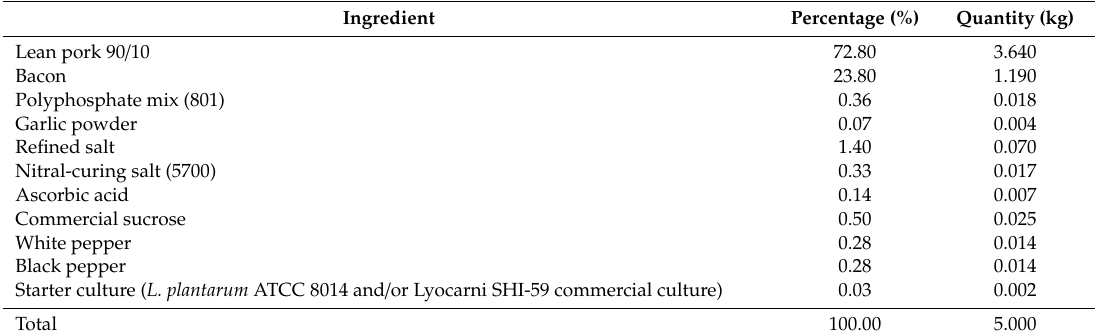
Table 2. Low acidity pepperoni